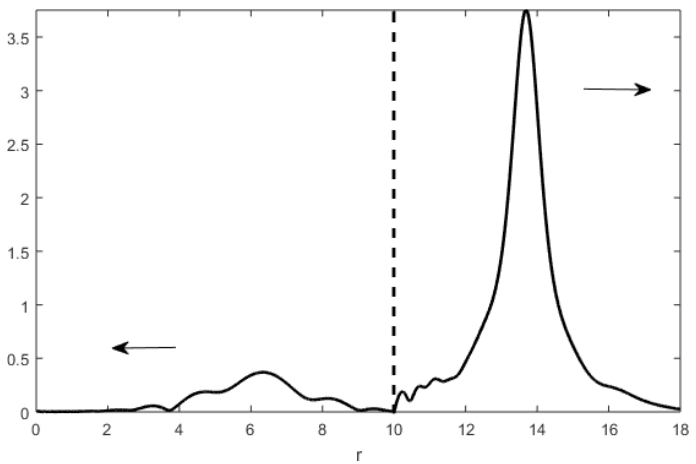
Figure 7. Solution profile after defect interaction for Z = 200 and t = 0.4320.